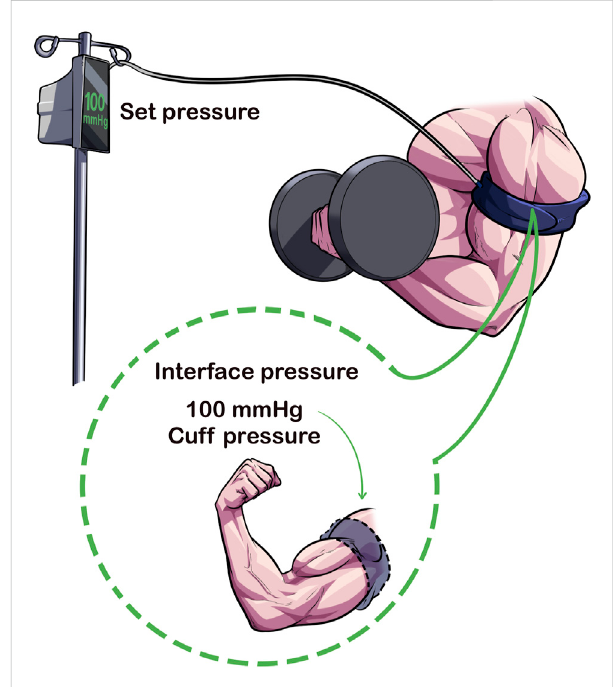
FIGURE 4 Set Pressure Versus Interface Pressure. The set pressure is the pressure that the pneumatic cuff is in fl ated to by the clinician/ exerciser/researcher whereas the interface pressure is the amount of pressure applied to the limb from the cuff. Cuffs that can maintain a similar set and interface pressures may enhance acute safety of BFR